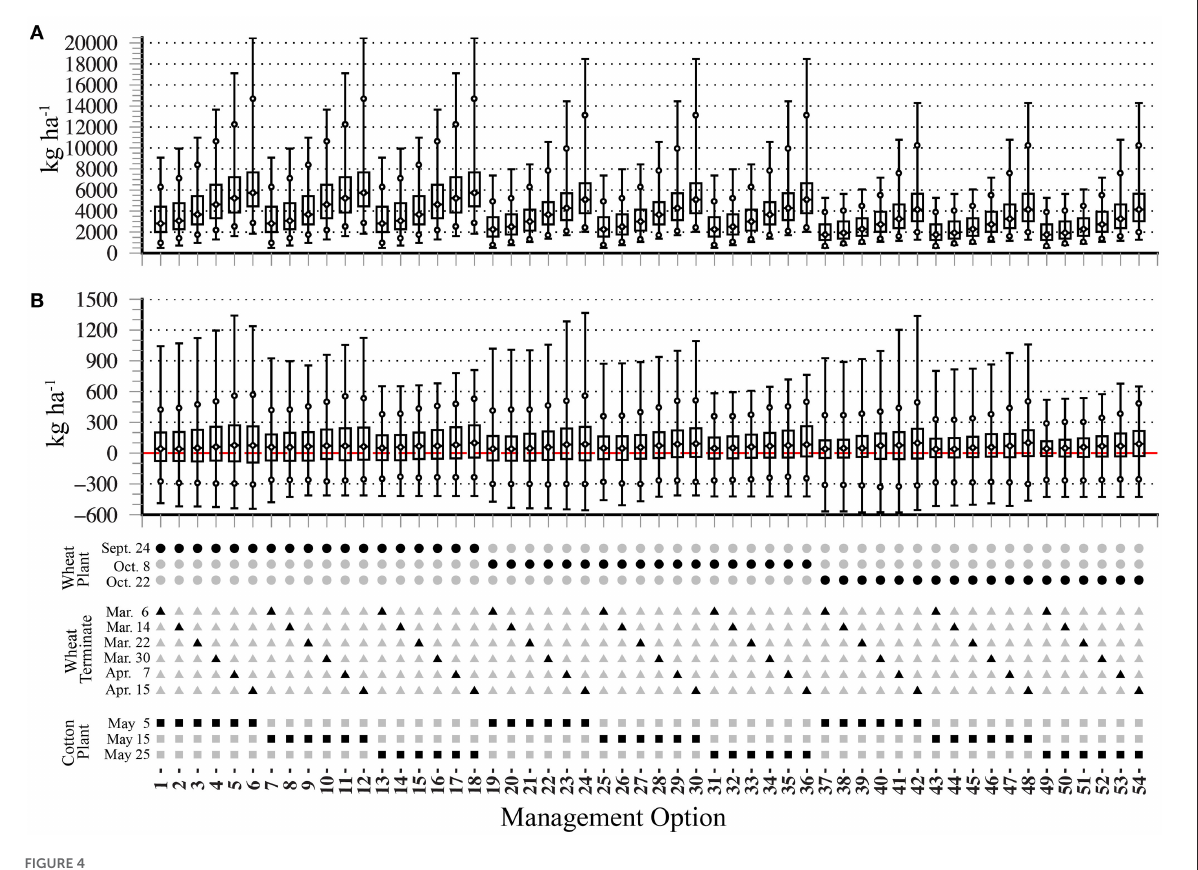
FIGURE4 (A) Distributions of wheat biomass at termination for each management option in the MFSL simulations. (B) Distributions of each management option’s WHCO minus FACO seed cotton yield effects in the MFSL simulations.